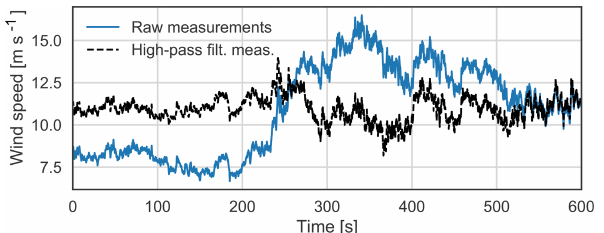
Figure 2. Wind speed measurements from 100m at Høvsøre, raw measurements (blue line), and high-pass filtered measurements (dashed black